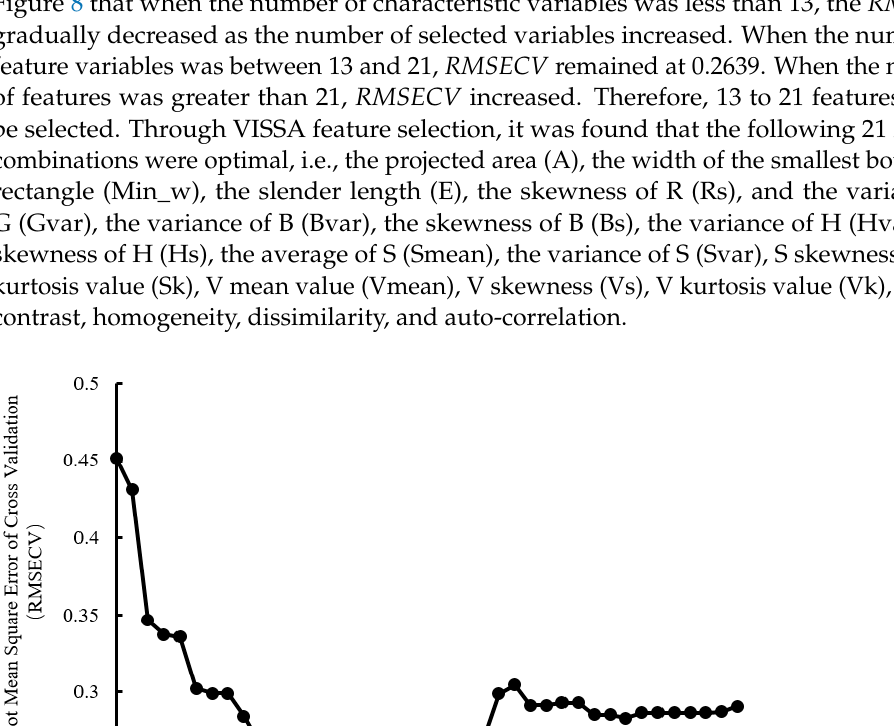
Figure 7. IRIV variable selection results based on image shape, size, color, and texture information.